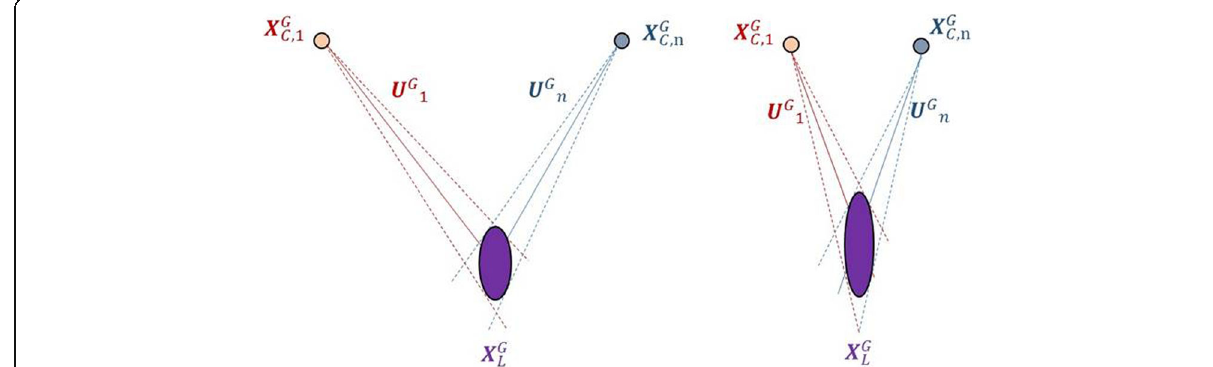
Fig. 4 SfM error model with two perspectives. A long displacement example is shown on the left , with the error of landmark location illustrated in a purple ellipse. On the right is a short displacement example, where the error is greater in the vertical